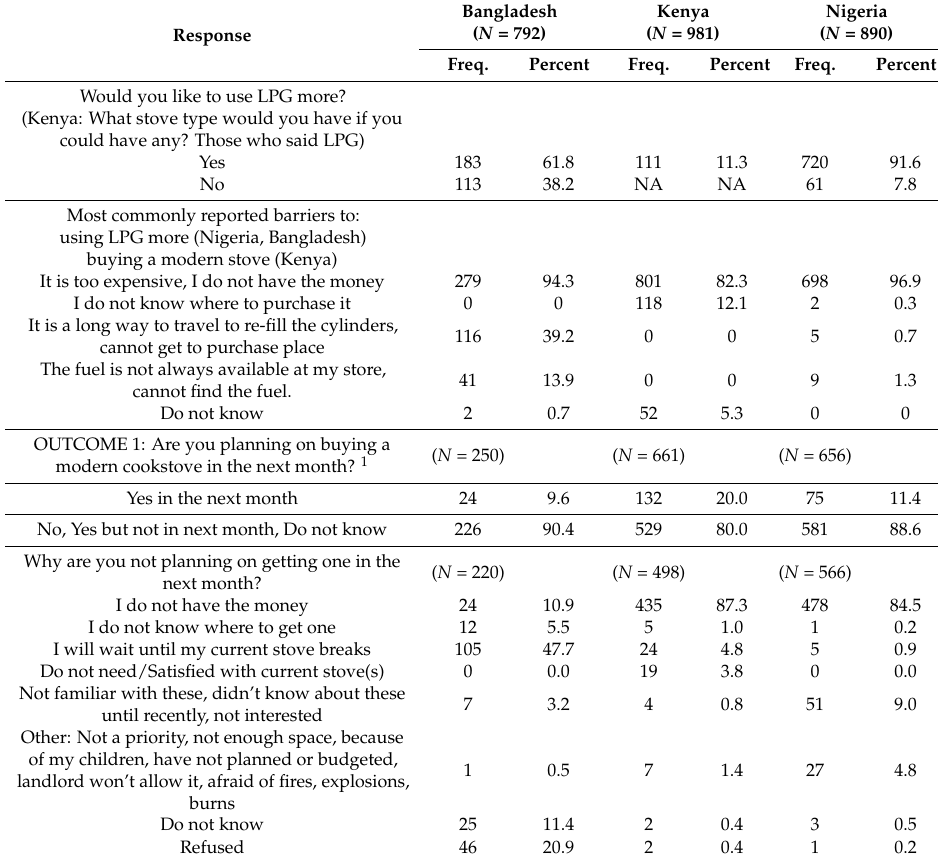
Kenya Nigeria ( N = 981) ( N = 890)